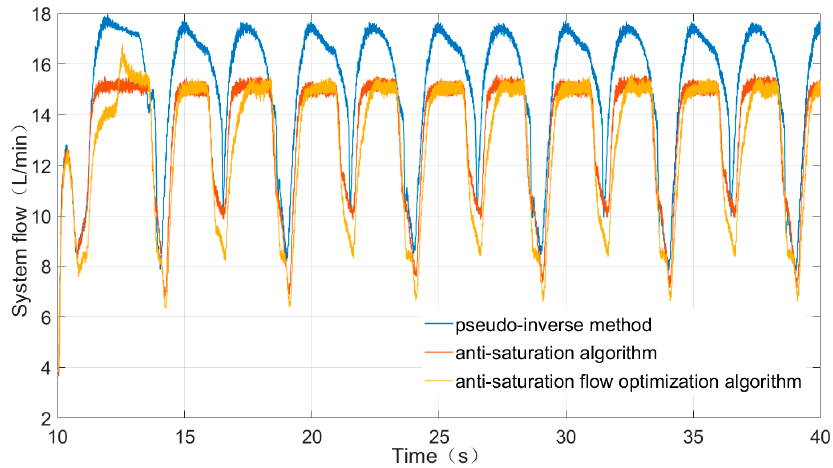
Figure 12. System flow comparison diagram-anti-saturation flow optimization algorithm experiment.